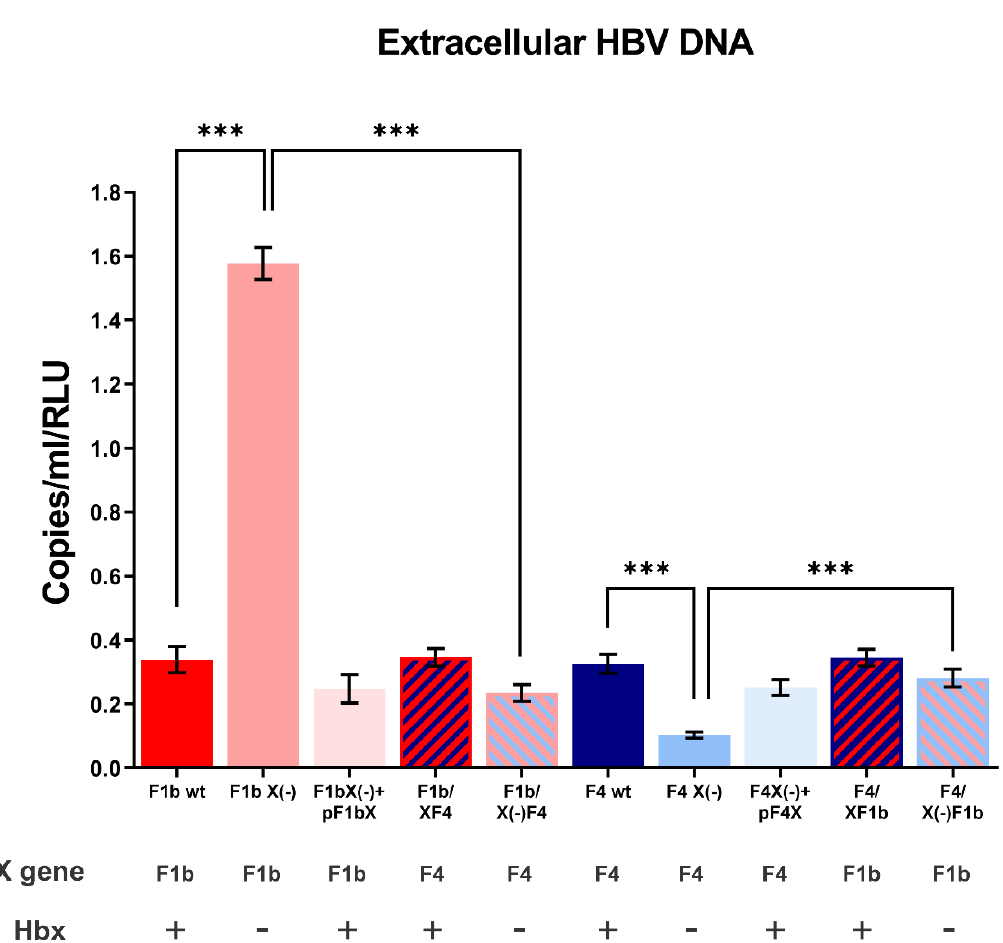
Figure 3. Analysis of extracellular HBV DNA of sgtF1b and sgtF4 variants. HuH-7 cells were transfected with linear full-length HBV genomes of F1b wt, sgtF1b X(-), F1b X(-) + pF1bX, F1b / XF4, F1b /